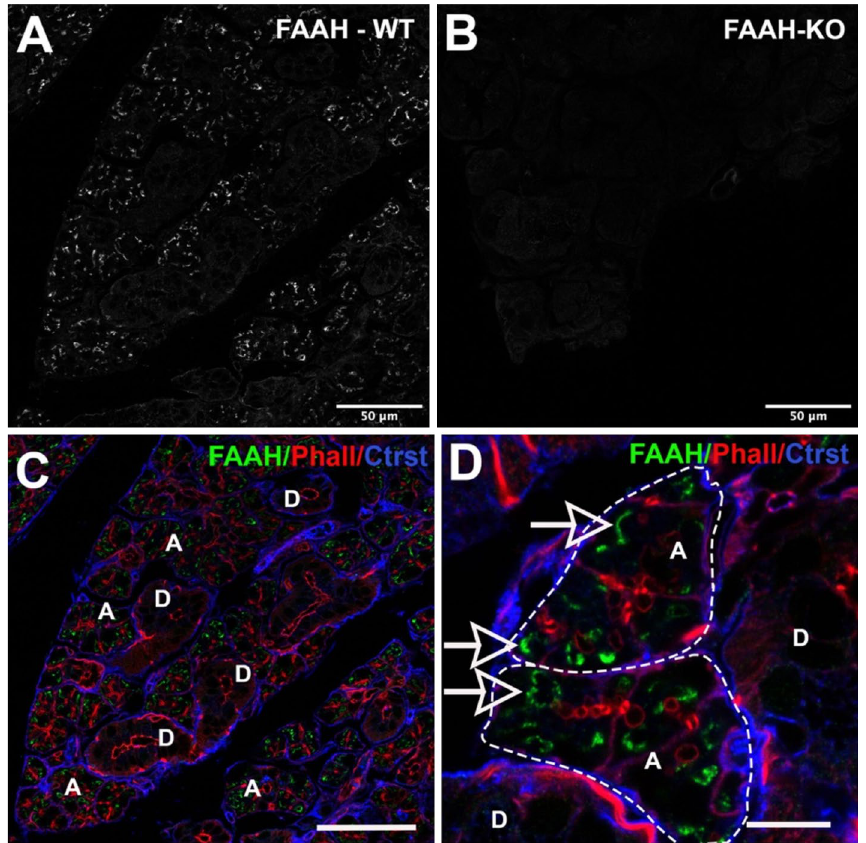
Figure 5. FAAH protein expression in acini of submandibular gland. ( A , B ) FAAH expression in ( A ) WT and ( B ) FAAH knockout submandibular gland. ( C ) Triple-stain from ( A ) shows FAAH (green) relative to phalloidin (red) and a counterstain that outlines acini. FAAH is seen in acini “A” but not ducts “D”. ( D ) Higher magnification image shows FAAH staining in acini “A”, outlined but not ducts “D”. Scale bars: ( A – C ) 50 µm; ( D ) 15 µm. Images processed using Adobe Photoshop vsn. 21.2 and FIJI (vsn 2.3.0/1.53q, available at https:// imagej. net/ Fiji/ downl